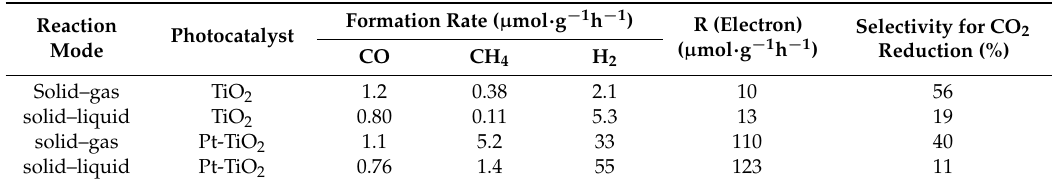
Table 3. Influence of reaction phase on photocatalytic reduction a of CO 2 with H 2 O using TiO 2 and 0.5 wt % Pt-TiO 2 photocatalyst